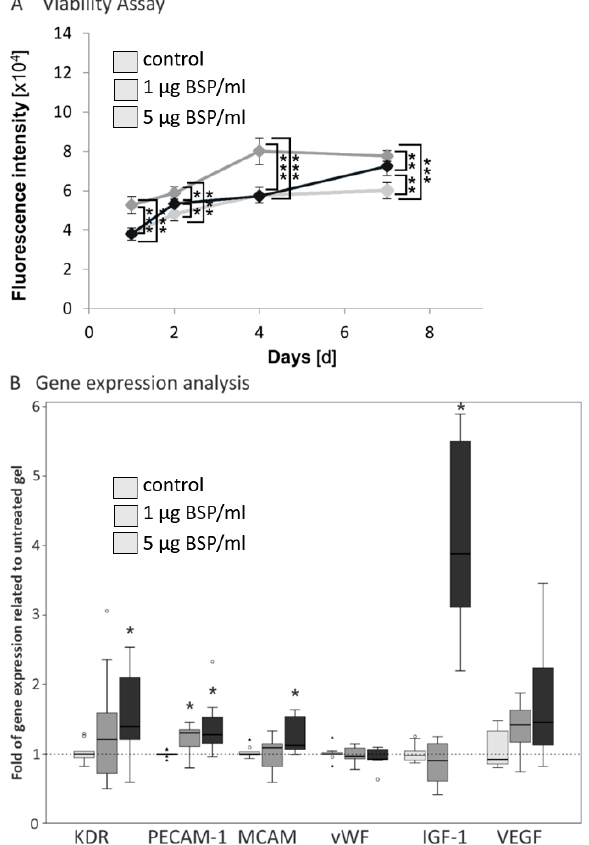
Figure 3. Cell viability and proliferation assay and gene expression analysis. ( A )—Cell viability of HUVECs in collagen gels with immobilized BSP. Results are expressed as mean ± SD ( n = 9). Games-Howell or Tukey-HSD post hoc tests (dependent on Levene’s test) revealed significant differences (** p < 0.01, *** p < 0.005). ( B )—Relative gene expression analyses in endothelial cells seeded in dif- ferent modified collagen gels compared with untreated collagen gels (gene expression = 1). Results are expressed as median and quartiles ( n = 9). Mann–Whitney-U tests revealed significant differ- ences (* p < 0.05, circles and triangles present outliners).